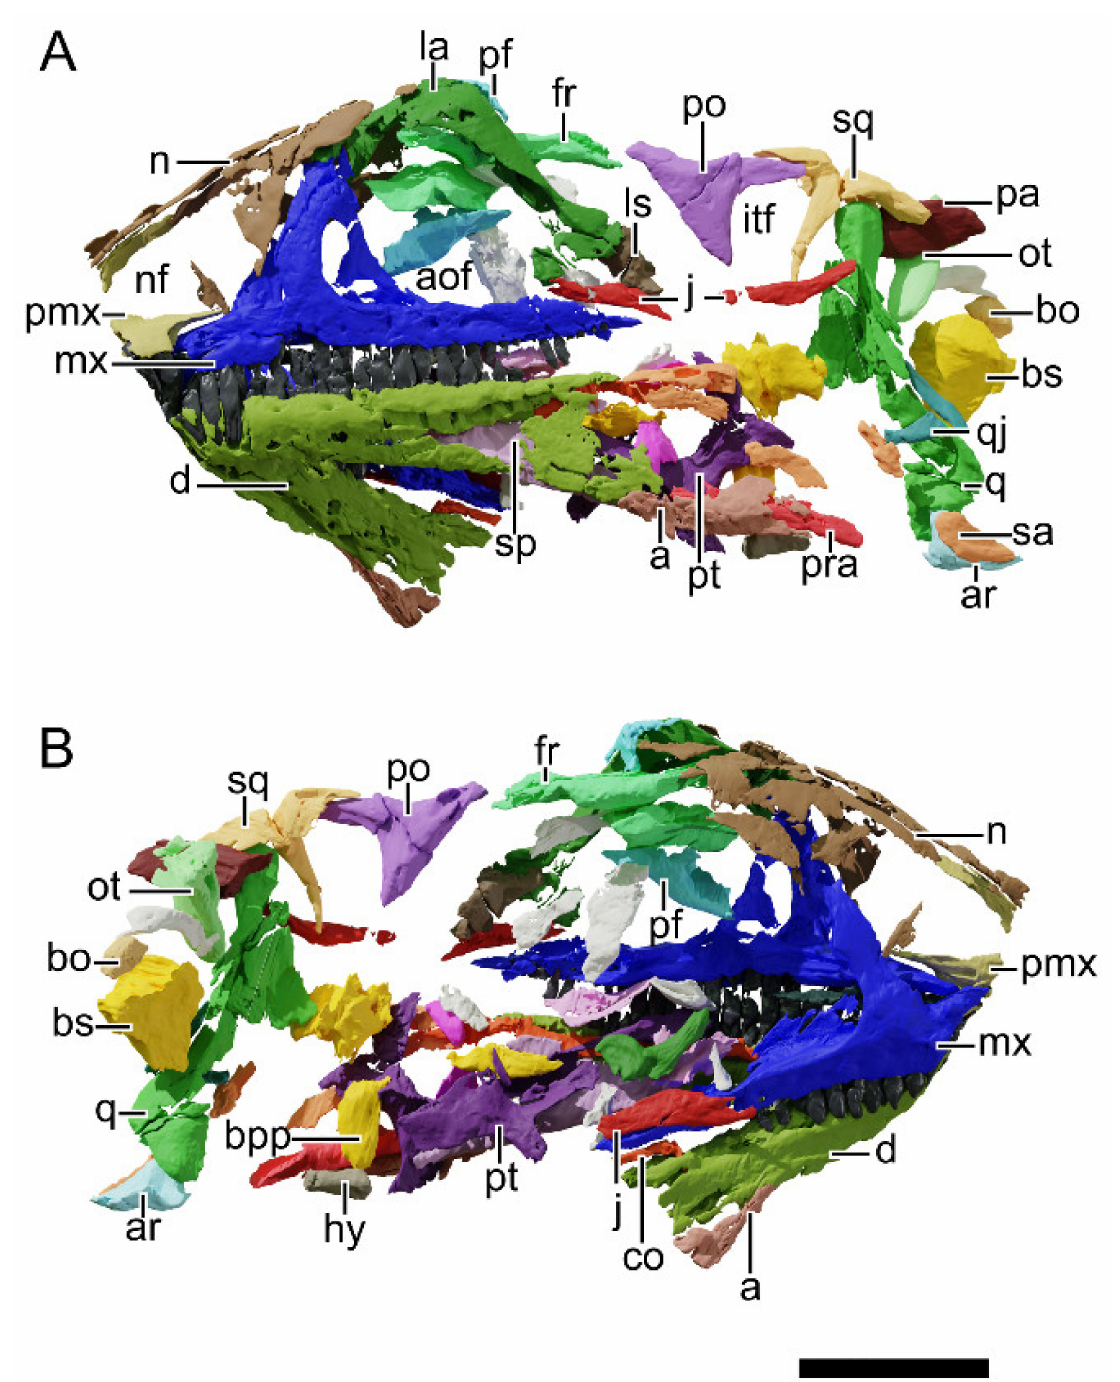
Figure 4. Digital reconstruction of the skull of NHMD 164741. ( A ) Left lateral view. ( B ) Right lateral view. Abbreviations: a, angular; aof, antorbital fenestra; ar, articular; bo, basioccipital; bpp, basipterygoid process; bs, basisphenoid; co, coronoid; d, dentary; fr, frontal; hy, hyoid; itf, infratemporal fenestra; j, jugal; la, lacrimal; ls, laterosphenoid; mx, maxilla; n, nasal; nf, narial fenestra; ot, otoccipital; pa, parietal; pf, prefrontal; pmx, premaxilla; po, postorbital; pra, prearticular; pt, pterygoid; q, quadrate; qj, quadratojugal; sa, surangular; sp, splenial; sq, squamosal. Scale bar = 50